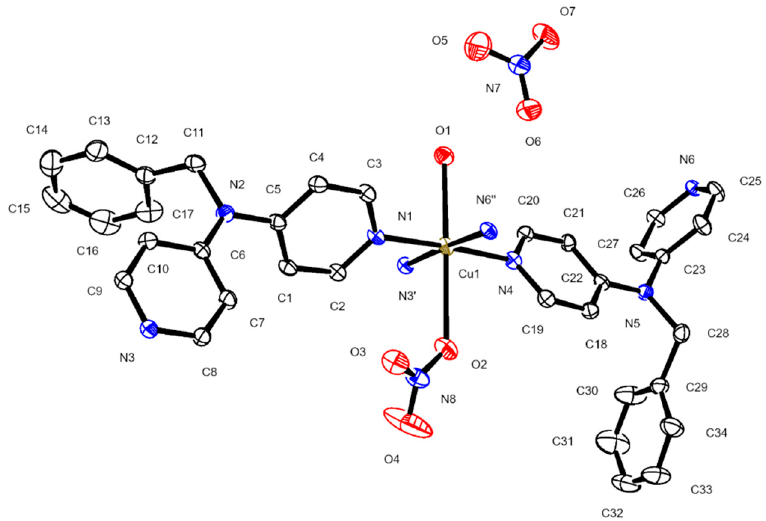
Figure 5. ORTEP drawing of polymer 2 . The thermal ellipsoids are shown at 30% level. The solvent molecules and hydrogen atoms are omitted for clarity.